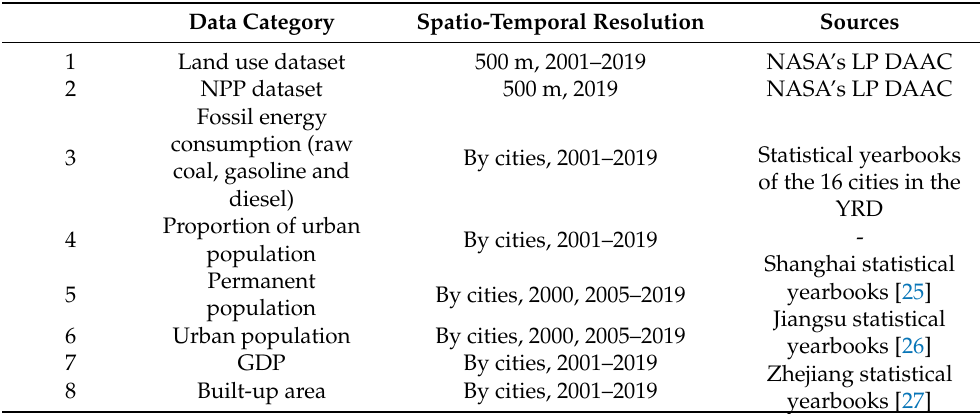
Table 1. Data sources in this study.